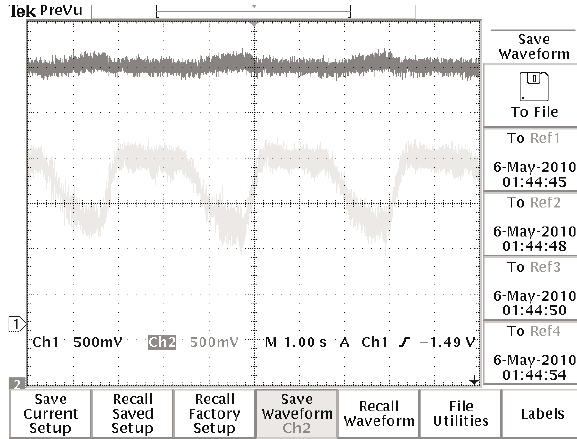
Fig. 7. CD with a periodic record and additional noise waveform. CD surface without the